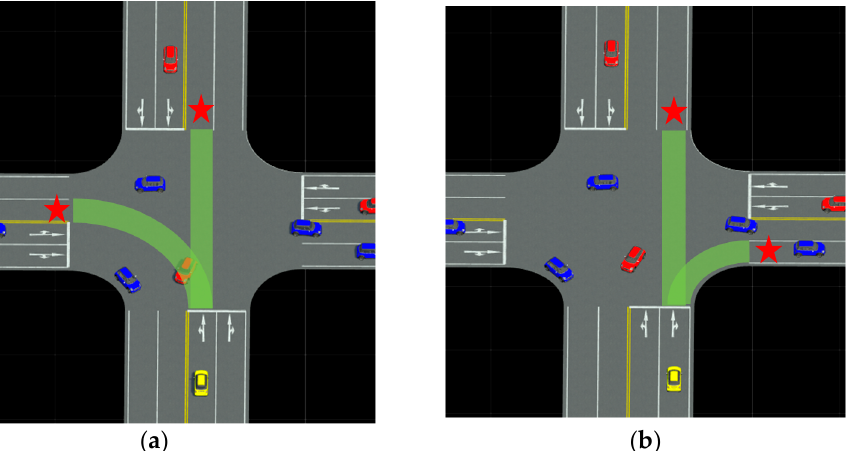
Figure 2. Intersection simulation environment: ( a ) left turn and straight ahead; ( b ) right turn and straight ahead.